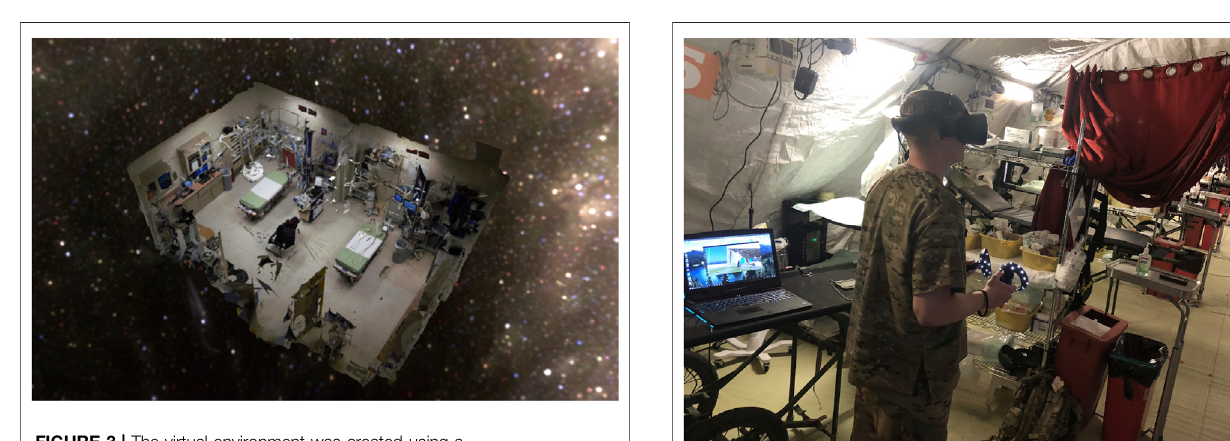
FIGURE 3 | The virtual environment was created using a photogrammetry 3D scan of the Madigan Army Medical Center trauma bay, a representative image from that scan is shown in this panel.